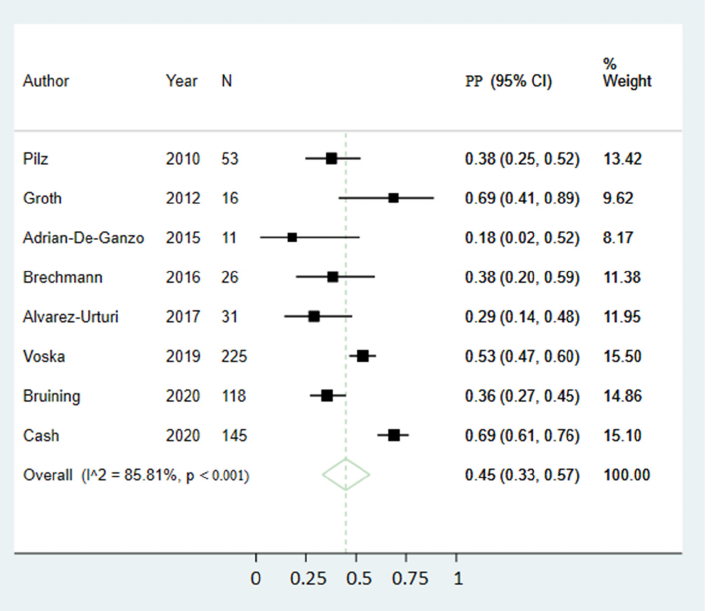
Figure 2. Pooled estimate of CCE preference proportion. Abbreviations: CI, confidence interval; PP, Estimated preference proportion.